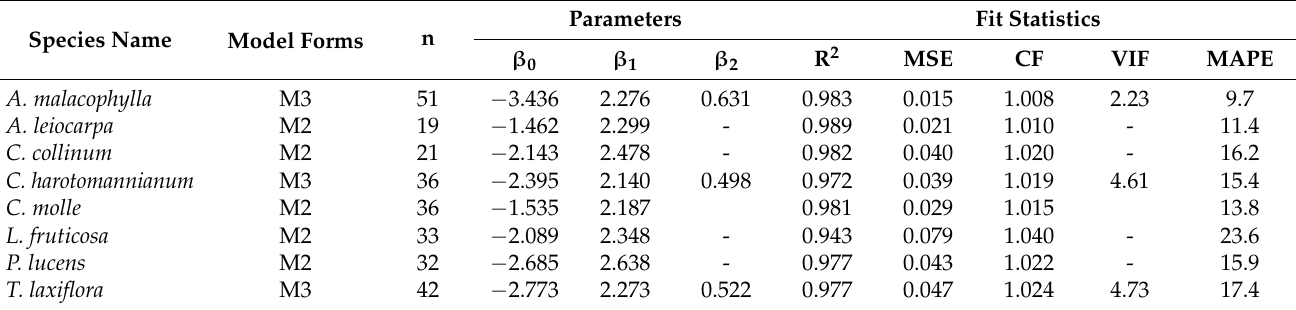
Table 1. The best species-specific models with their parameters, a bias correction factor (CF), and fit statistics. Where MSE, R2, VIF, and n refer to, respectively, the mean squared error, adjusted coefficient of determination, variance inflation factor, and the number of sample